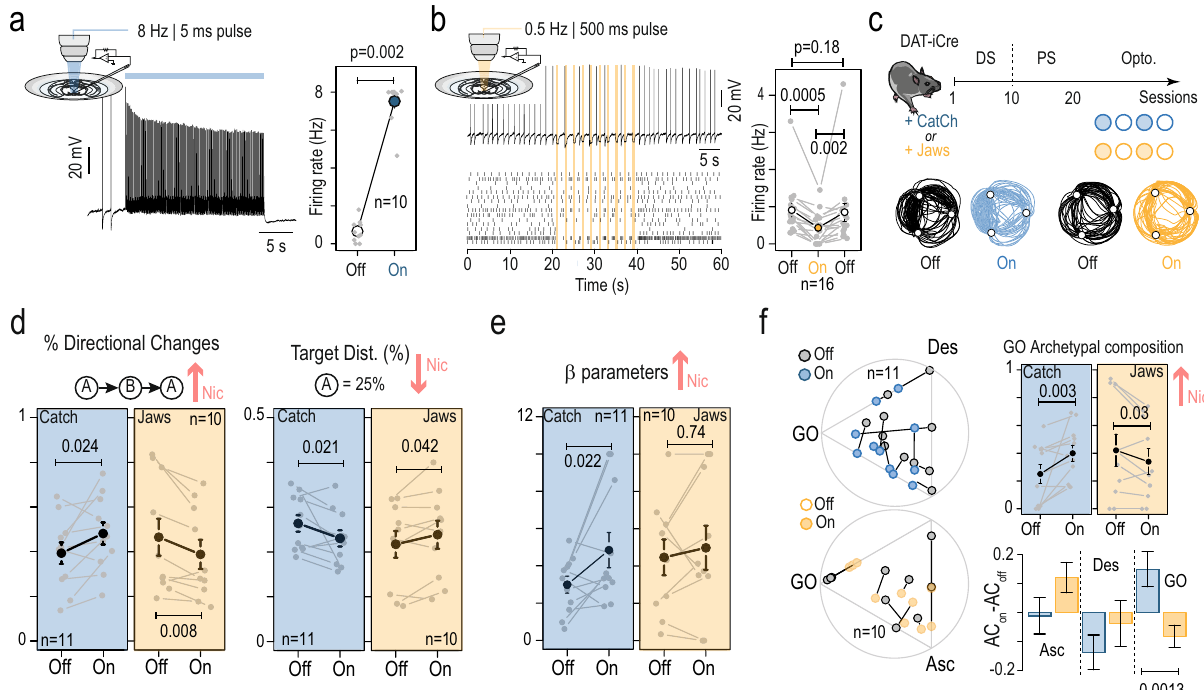
Fig. 5 Optogenetic manipulation of VTA DA neuron activity recapitulated the behavioral adaptations observed under chronic nicotine exposure. a Left: representative ex vivo current-clamp recording of a VTA DA neuron transduced with CatCh and stimulated with 5 ms blue light pulses at 8 Hz. Right: average increase in basal fi ring frequency upon optogenetic stimulation for n = 10 neurons ( p value = 0.002, two-sided Wilcoxon test). b Top left: representative ex vivo current-clamp recording of a VTA DA neuron transduced with Jaws and stimulated with 500 ms green light pulses at 0.5 Hz. Bottom left: raster plot for n = 16 neurons. Right: average decrease in basal fi ring frequency upon optogenetic stimulation, and return to the baseline after the photo-stimulation period, for n = 16 neurons ( p value: ns = 0.18; ** 0.004; ** 0.0014, two-sided Wilcoxon test with Holm correction). c Task design and photo-stimulation protocols. DAT iCRE mice transduced with either an AAV-DIO-CatCh-YFP in the VTA (CatCh, blue) or an AAV-DIO-Jaws-eGFP (Jaws, yellow) and were implanted unilaterally with bipolar stimulating electrodes for ICSS in the MFB (see also Supplementary Table 1). Following the deterministic (DS) and probabilistic setting (PS) sessions, they received 2 paired Off ( fi lled circles) and Off (open circles) sessions with the same rules as in the PS. Below: representative trajectories of a CatCh and Jaws-transduced mouse with (blue and yellow) and without (black) optogenetic stimulation of VTA DA neurons. d Left: percentage of directional changes and (right) target distribution (P 25 ) in individual mice (gray points) for CatCh ( n = 11) and Jaws- transduced ( n = 10) mice during On and Off sessions. Mean + sem are in black. Red arrows indicate the net effect of nicotine for comparison (one-sided Student ’ s t -test or Wilcoxon test). e Same as ( d ) for the softmax model β parameter. f Left: position of each animal in the ternary archetype plot for CatCh ( n = 11, above) and Jaws-transduced ( n = 10, below) mice, in On (blue or yellow points) and Off (gray point) sessions. Right: (above) GO archetypal composition in individual mice (gray points) during On and Off session, for CatCh ( n = 11) and Jaws-transduced ( n = 10) mouse. Mean + sem are in black; (below) net effect (ON – OFF) of light stimulation in archetypal composition for each archetype. Optogenetic activation of DA neurons triggered a shift of the behavior towards the GO phenotype while optogenetic inhibition induced a shift of the behavior away from GO (one-sided Student ’ s t -test). For ( a , b ) and ( d , f ), data are shown as mean ± sem. See also source